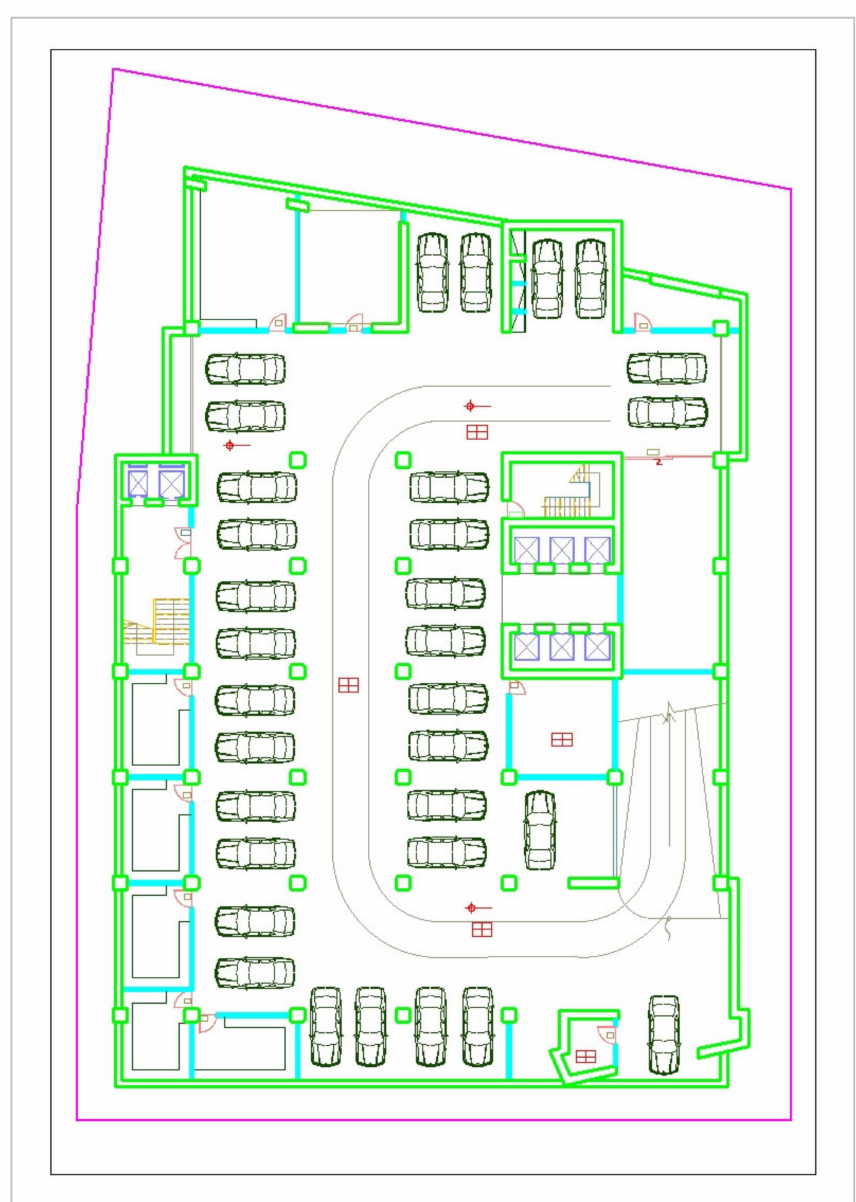
Figure 3. Floor plan for underground parking (source: ETG Designers and Consultants